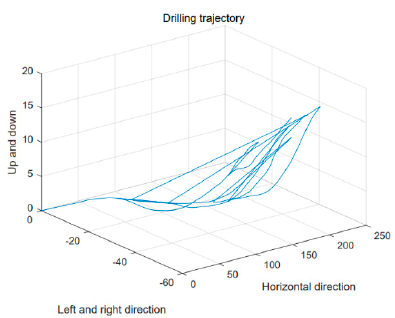
Figure 1. Visualization of drilling trajectory.